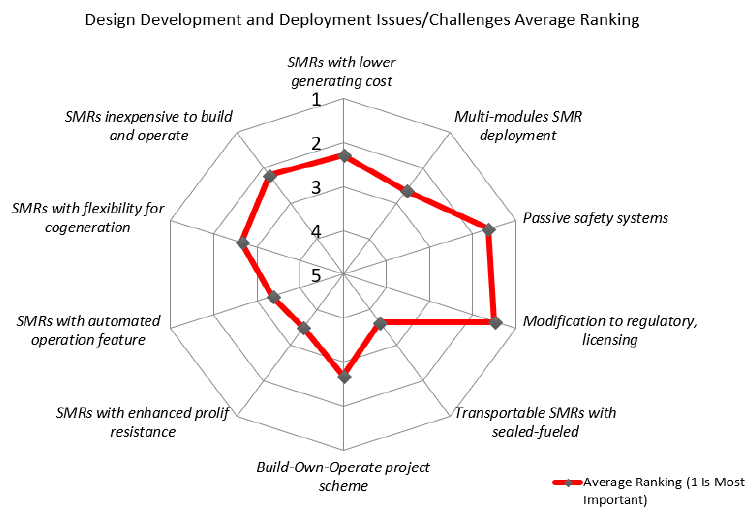
Figure 1. Average ranking of identified challenges for design development and deployment [1]. Reproduced from [1], IAEA: 2016.